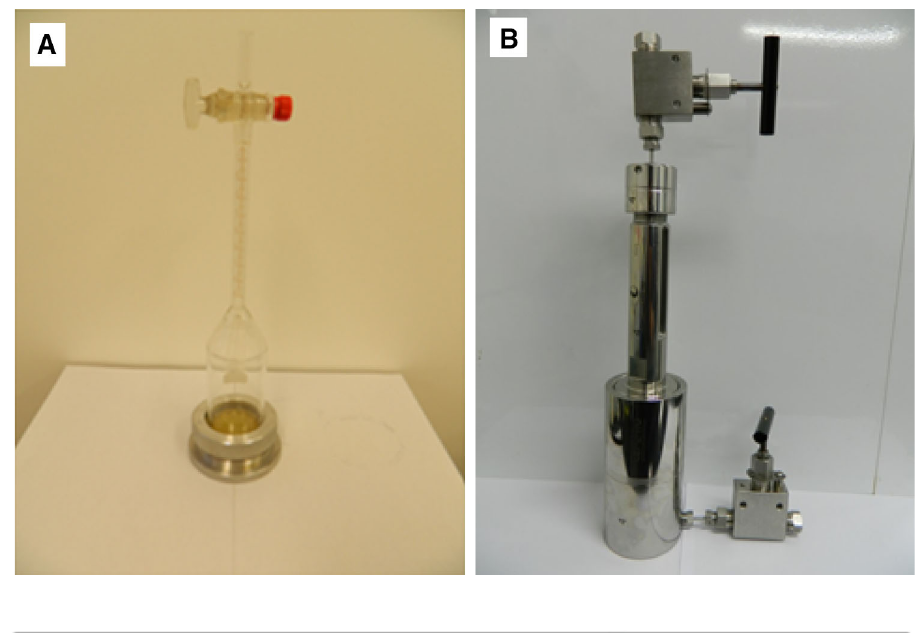
Fig. 2 Experimental setup